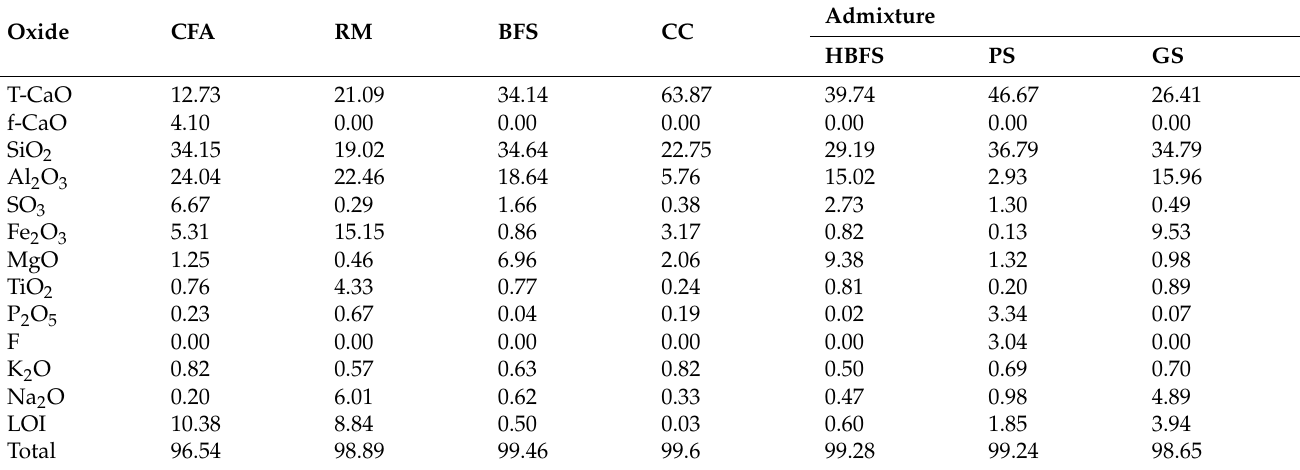
Table 1. Chemical composition of raw materials.